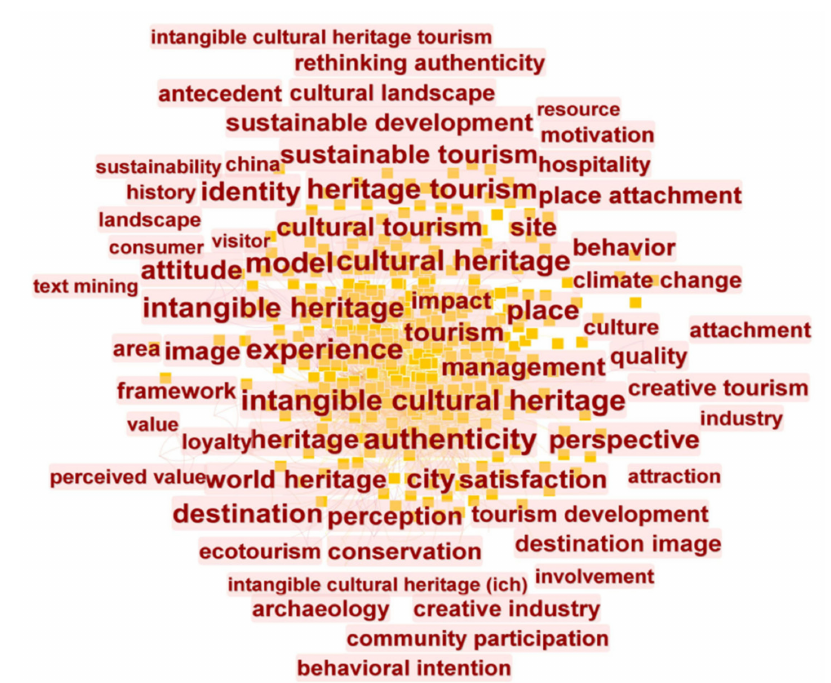
Figure 4. Co-occurrence network of keywords in foreign